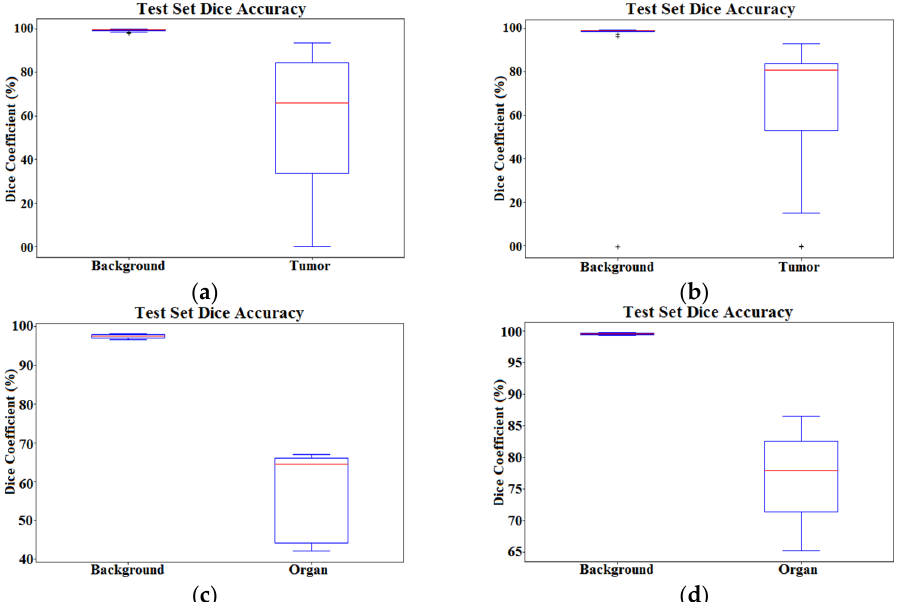
Figure 9. Boxplots for comparing between the efficiency of ( a ) conventional U ‐ Net(3) and ( b ) AID ‐ U ‐ Net (2, 1), applied to brain CT scans for detecting and localizing brain tumors. Boxplots for comparing between the efficiency of ( c ) conventional U ‐ Net (3) and ( d ) proposed AID ‐ U ‐ Net (2, 1), applied to 3D abdomen CT scans for detecting and localizing the prostate gland. The red lines in the plot present the median dice value for the classes, while upper and lower bounds of blue boxes indicate the 25th and 75th percentiles, respectively. Black whiskers extend to the most extreme data points that are not outliers. Head ‐ to ‐ head